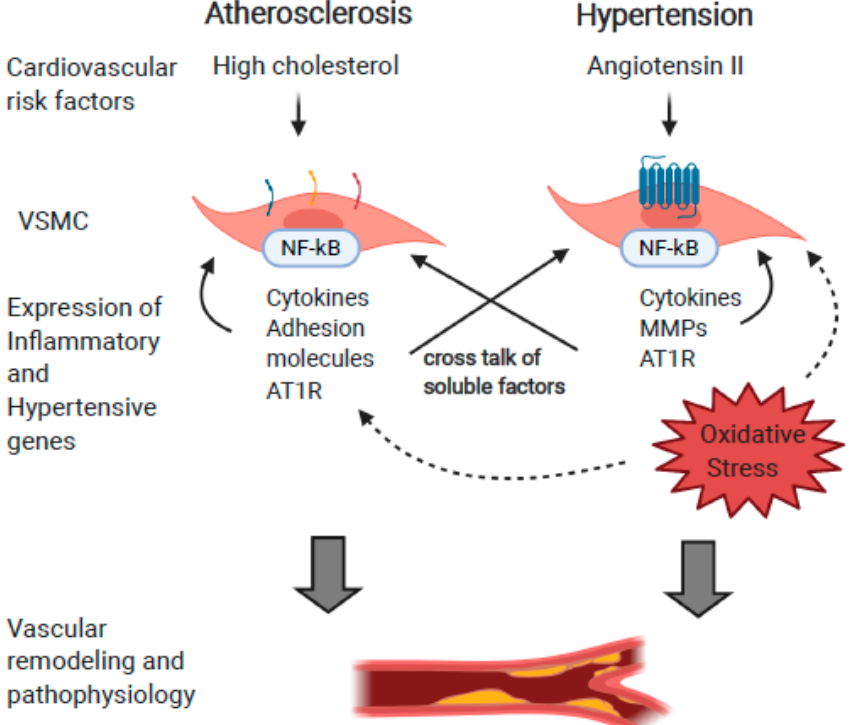
Figure 2. Systemic, cellular, and molecular intersections between hypertension and